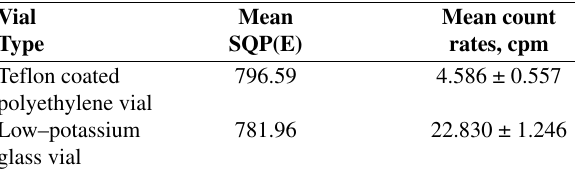
Table 1. The vial effect on quenching, SQP(E) 6 mL deionized wa- ter + 14 mL UG AB, pH = 1.70 ± 0.05, counting time = 15 min